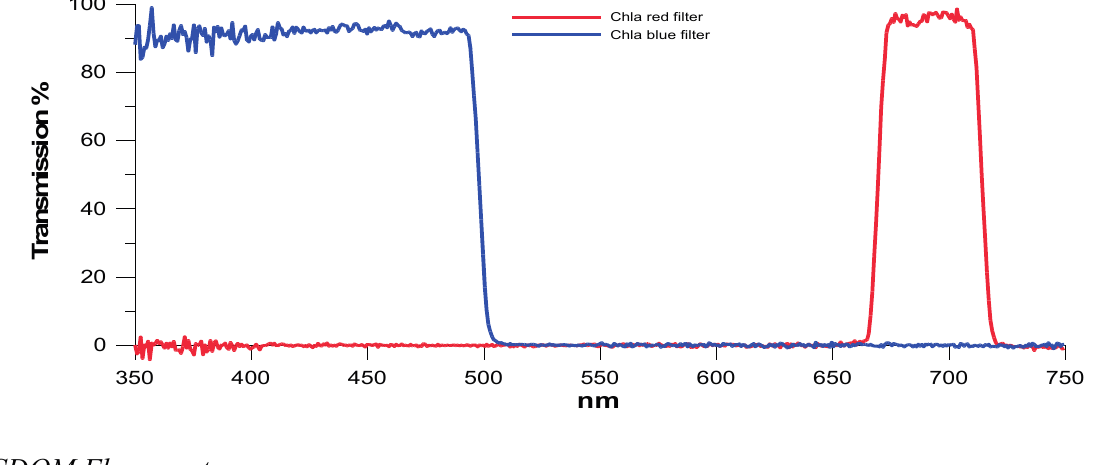
Figure 4. Transmission spectra of the optical filters in the excitation ( Blue Curve ) and in the detection ( Red Curve ) modules obtained by an Ocean Optics QE65000